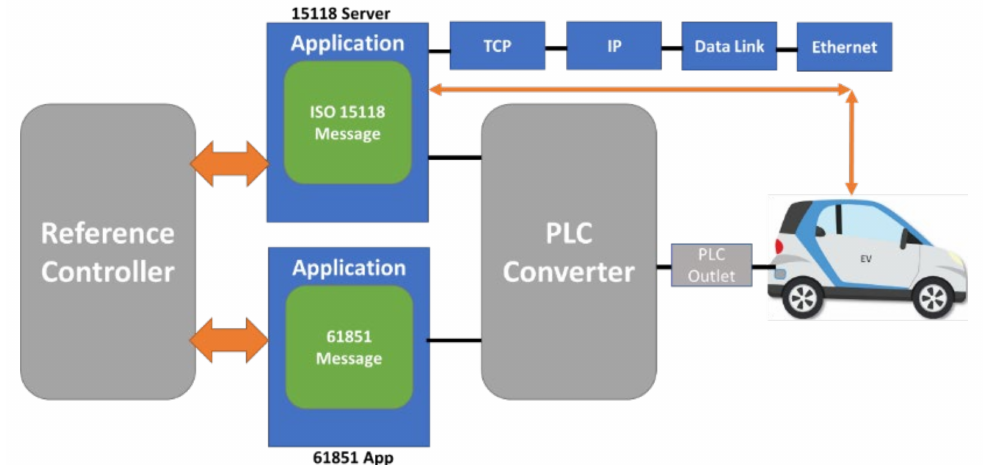
Figure 18. Communication architecture implemented during V2G testing.